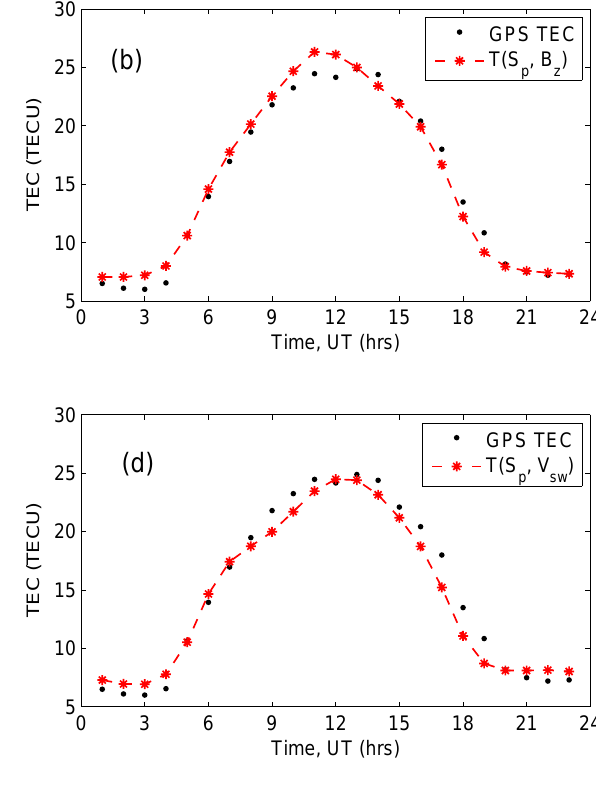
Fig. 6. Similar to Fig. 3, for day 285 in